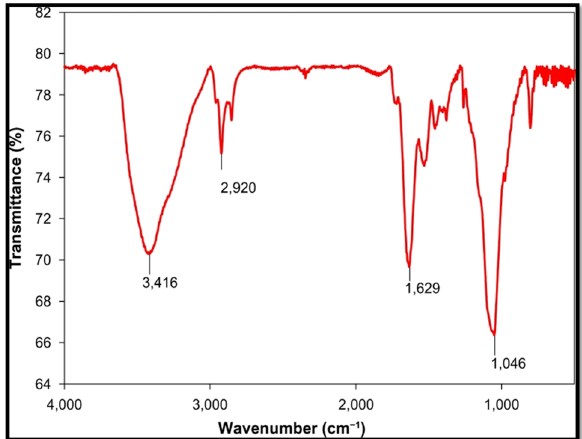
Figure 7: FTIR spectroscopy analysis of AgNPs revealing absorption peaks of phytochemicals in plant extract.